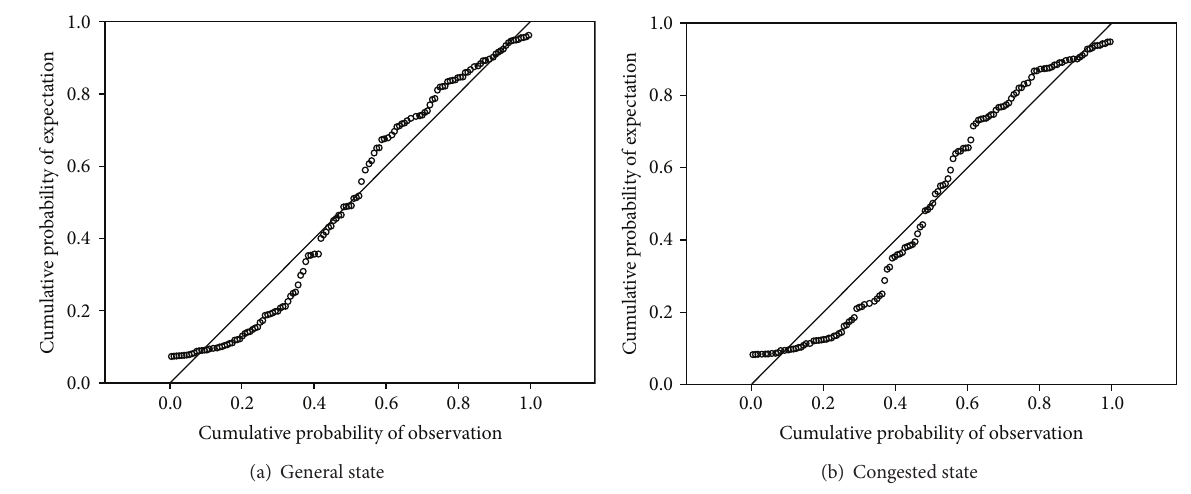
Figure 9: P-P figure of normal distribution